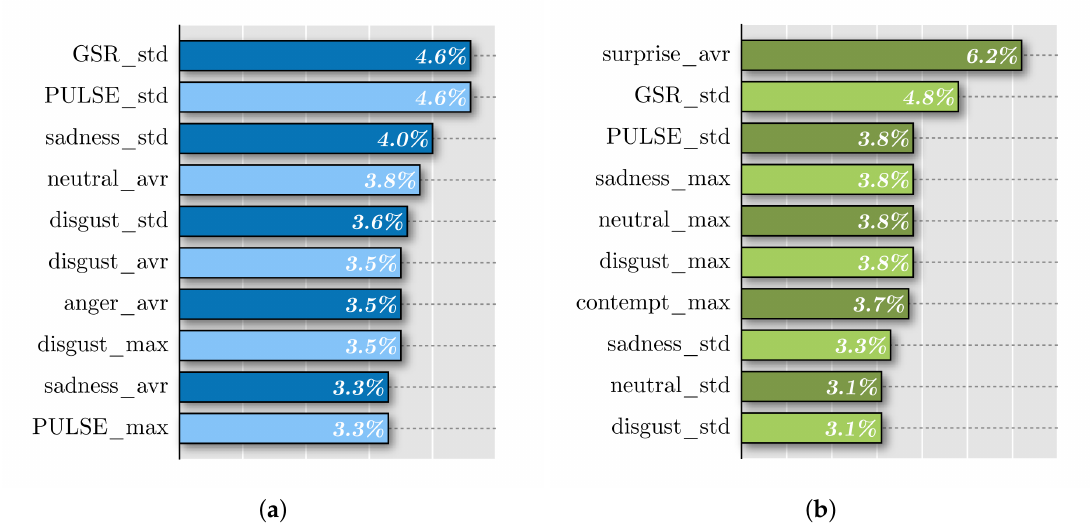
Figure 15. Feature importance: ( a ) taste and ( b ) smell regression